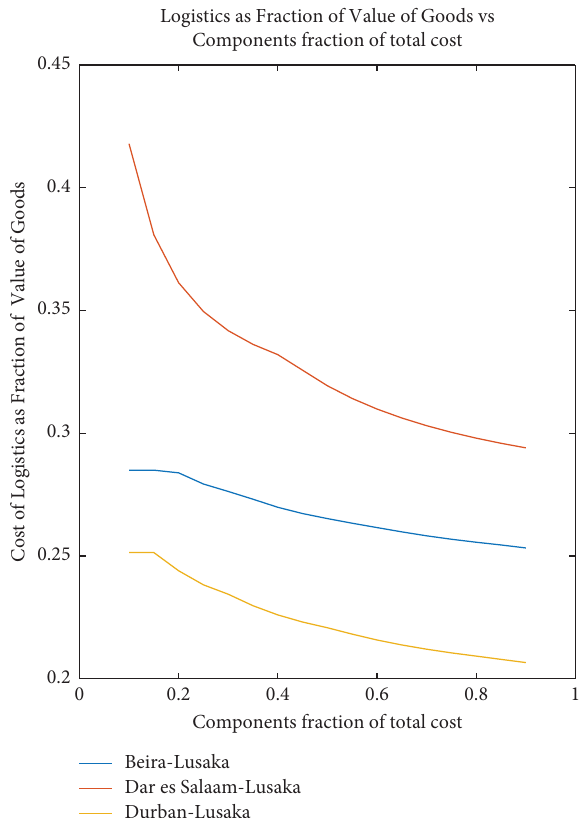
Figure 6: Logistics cost is a fraction of the cost of cargo for diferent values of component cost as a fraction of total